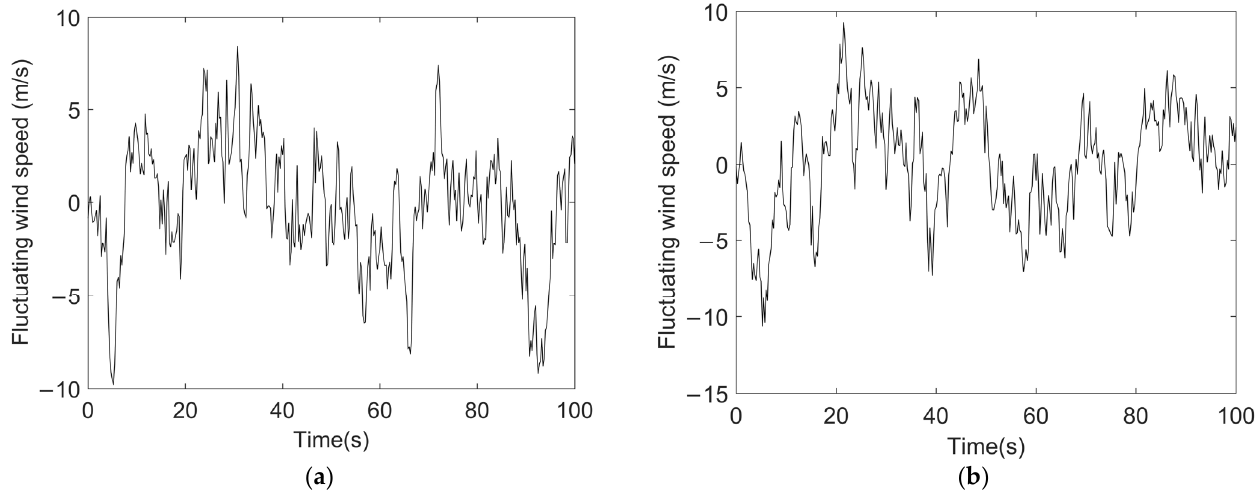
Figure 5. Simulated fluctuating wind speed, ( a ) The 10th floor, ( b ) The 20th floor.